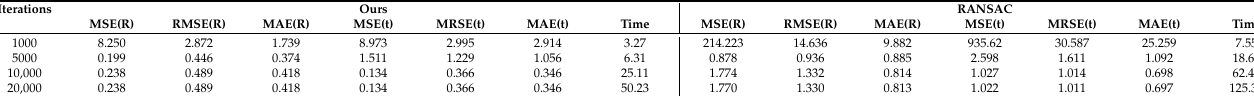
Table 5. Registration error and time of different max iterations.